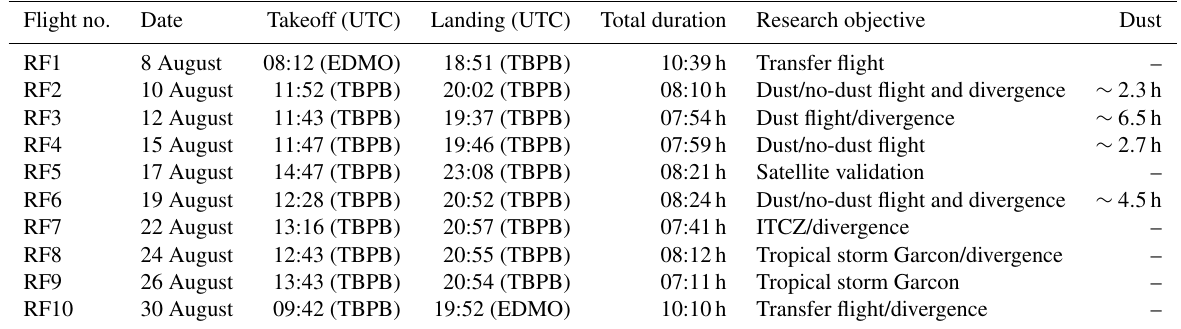
Table 1. Overview of the conducted research flights during NARVAL-II in 2016 including dates, times of takeoff and landing, total duration of flights, research objectives, and flight hours in SAL regions (all times given in UTC; note Atlantic standard time is UTC − 4; TBPB: Grantley Adams International Airport; EDMO: Airport Oberpfaffenhofen). Flight no.